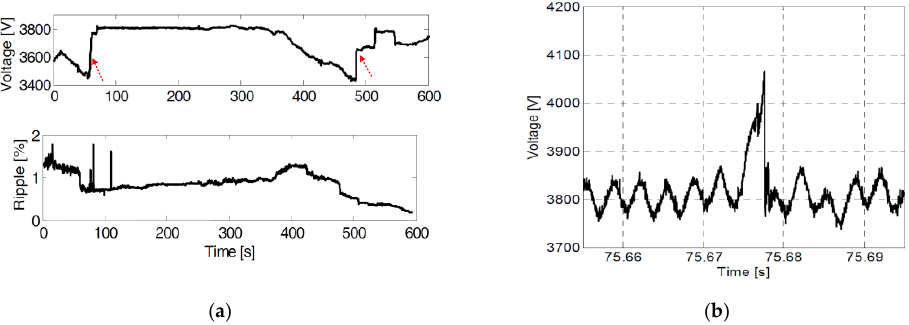
Figure 12. Measured transient voltage in 3 kV DC Italian ERPS [102]. ( a ) Caused by sudden generated tractive effort. ( b ) Caused by passing neutral section and changing supplying TPSS.